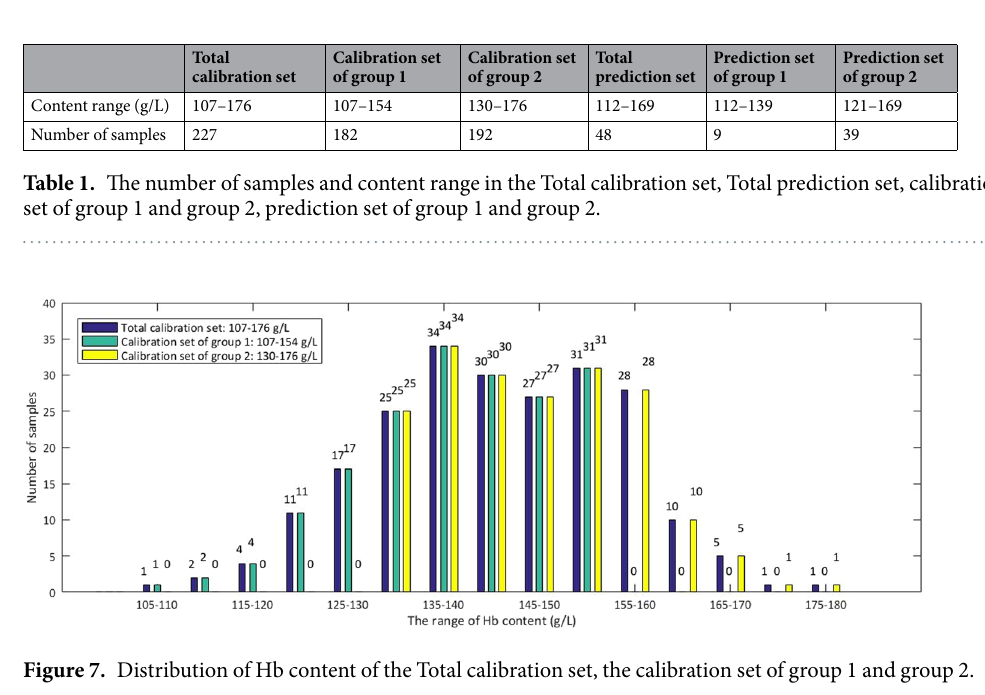
Figure 7. Distribution of Hb content of the Total calibration set, the calibration set of group 1 and group 2.